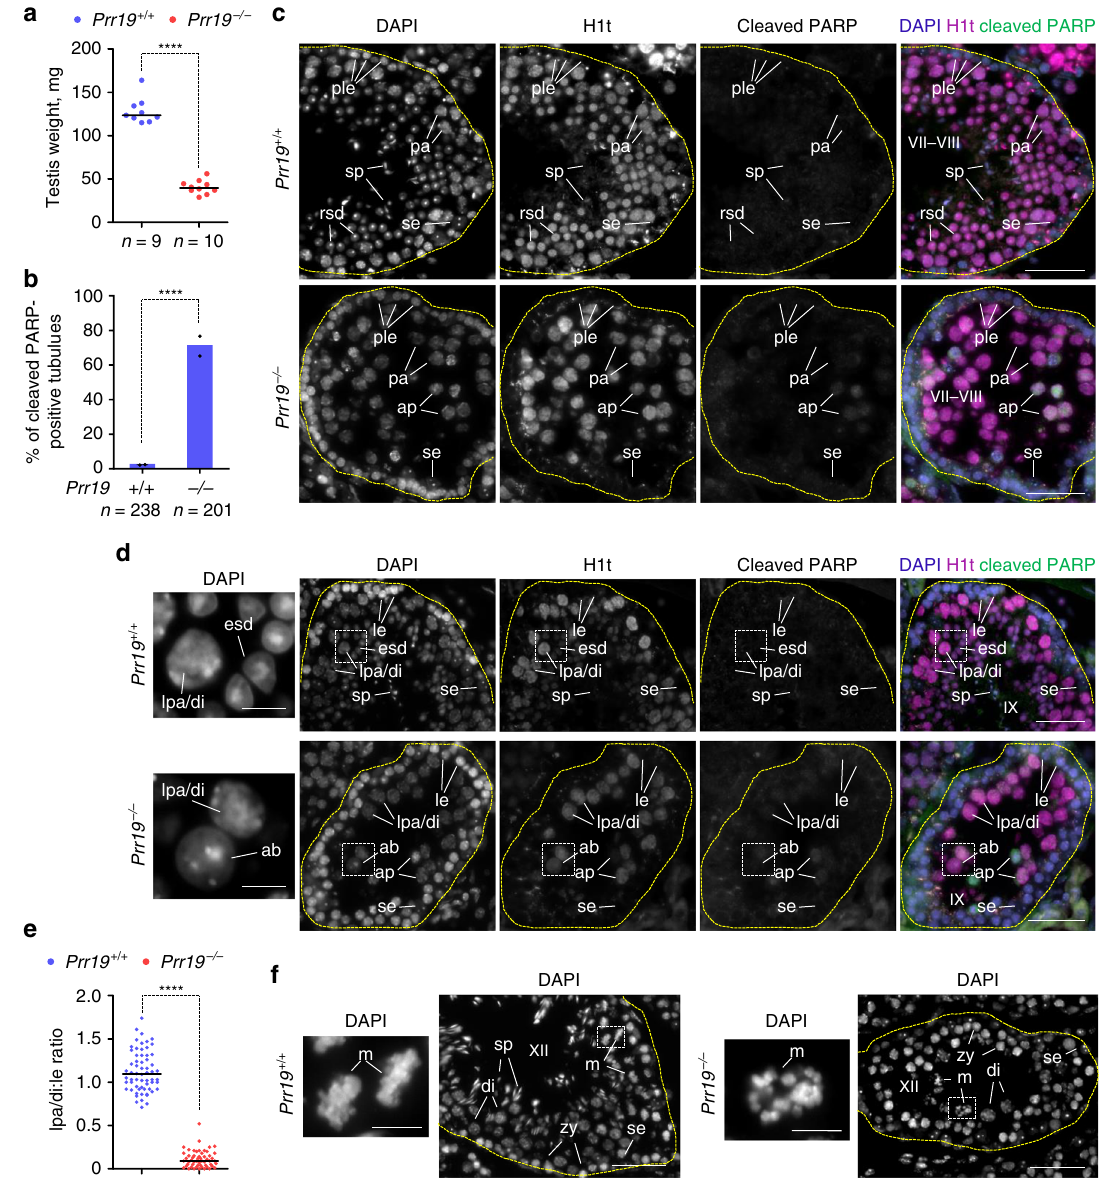
Fig. 3 Depletion of late prophase spermatocytes in PRR19-de fi cient males. a The average single testis weights in adult wild-type and PRR19-de fi cient mice. The number of analysed animals ( n ) and medians (bars, wild-type, 123.5 mg, Prr19 − / − , 39.55 mg) are indicated. Mann – Whitney U test calculated P = 2.17E-05. b Quanti fi cation of seminiferous tubules that contain cleaved PARP-positive apoptotic spermatocytes in the pachytene/diplotene layer. Graph shows datapoints and weighted averages of percentages of seminiferous tubules. n = number of tubules counted in two independent experiments. An analysis of deviance using the likelihood-ratio test based on the chi-squared distribution was used to calculate if the proportion of apoptotic seminiferous tubules is signi fi cantly altered by the loss of PRR19, P = 2.2E-16 (****). c , d , f Images show DNA staining by DAPI and ( c , d ) immunostaining of histone H1t (staging marker of seminiferous tubules) and cleaved PARP (marker of apoptosis) in sections of testes from adult wild-type and Prr19 − / − mice. Seminiferous tubules in epithelial cycle stages VII – VIII ( c ), IX ( d ) and XII ( f ) are shown; see ‘ Methods' for staging. Sertoli cells (se), preleptotene (ple), leptotene (le), zygotene (zy), pachytene (pa), late pachytene (lpa), diplotene (di) and metaphase (m) spermatocytes, round (rsd) and elongating (esd) spermatids, sperm (sp), H1t-positive cells with abnormal nucleus morphology (ab) and apoptotic spermatocytes (ap) are marked. Outlines of tubules (yellow dashed line) and tubule stages are indicated. Enlarged insets show abnormal H1t-positive cells in Prr19 − / − and corresponding spermatids in wild- type seminiferous tubules (side panel, d ), or misaligned metaphase chromosomes in Prr19 − / − and orderly metaphase plates in wild-type seminiferous tubules ( f ). ( c , d , f ) Bars, 50 µ m; enlarged insets ( d , f ) 10 µ m. e The ratios of late pachytene-diplotene to leptotene spermatocyte numbers (lpa/di:le) were quanti fi ed in stage IX seminiferous tubules in testis sections from adult wild-type and PRR19-de fi cient mice. n = numbers of analysed tubules from six (wild-type) or fi ve ( Prr19 − / − ) animals; medians (bars, wild-type, 1.09, Prr19 − / − , 0.09) were compared using Mann – Whitney U test, P < 2.2E-16 (****). Source data are provided as a Source Data fi